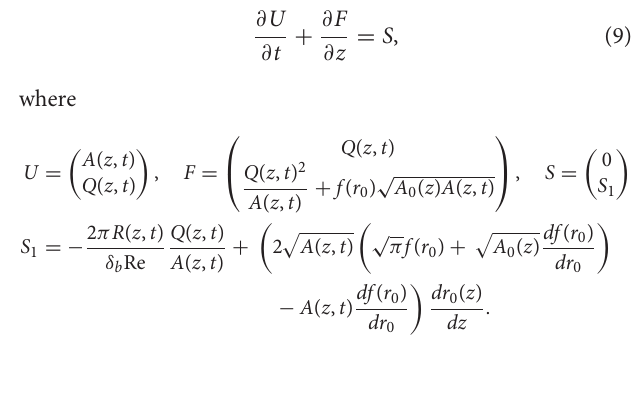
TABLE 1 | Geometry parameters of the MCA section modeled using VaMpy (Diem and Bressloff, 2016). MCA (cm) Left daughter Right daughter vessel